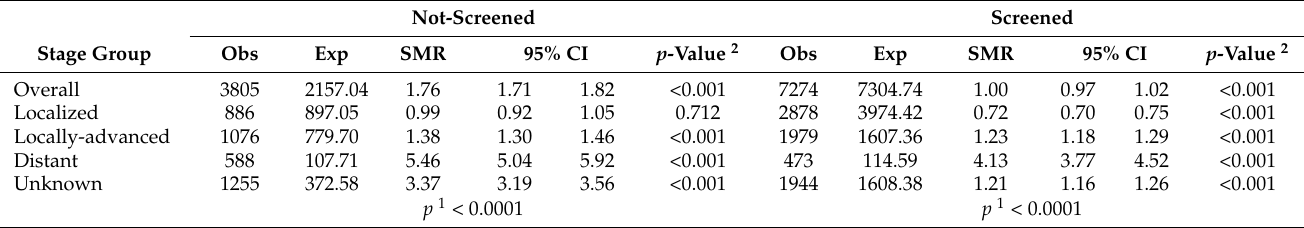
Table 3. Stage-specific standardized mortality ratios of screened and not-screened persons.